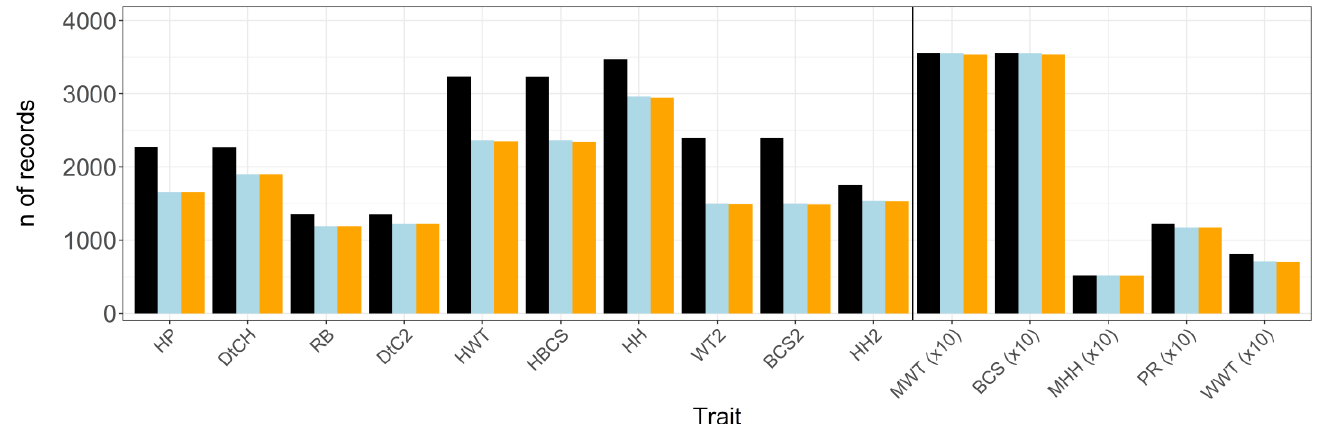
Figure 1. Original size of dataset (black bar) and number (n) of records after animals with missing contemporary group (CG) and/or age of animal or dam information (blue bar) as well as outliers (orange bar) have been removed from the dataset; n of records were divided by 10 for traits presented to the right of the divide; HP = pregnancy rate of 15-month-old heifers; DtCH = days to conception in 15-month-old heifers; RB = rebreeding performance in 2-year-old cows; DtC2 = days to conception in 2-year-old cows; HWT = live weight of 15-month-old heifers; HBCS = body condition score of 15-month-old heifers; HH = hip height of 15-month-old heifers; WT2 = live weight of 2-year-old cows; BCS2 = body condition score of 2-year-old cows; HH2 = hip height of 2-year-old cows; MWT = mature cow live weight; BCS = body condition score of mature cows; MHH = hip height of mature cows; PR = pregnancy rate of mature cows; WWT = weaning weight of calves.